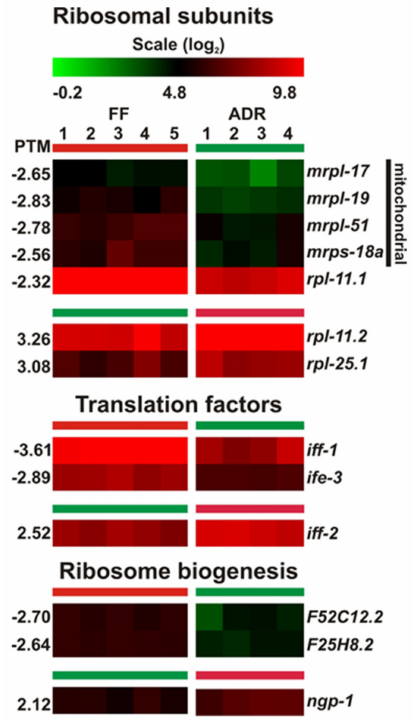
Figure 11. Heatmap of DEGs involved in translation regulation. Panel top: mitochondrial ribosomal subunit genes are generally down-regulated, while the other genes involved in translation and ribosomal biogenesis show up- and